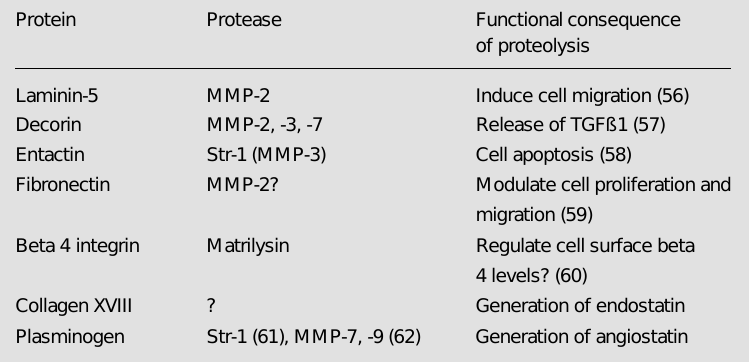
Table 2 - Consequences of protein cleavage by matrix metalloproteinases